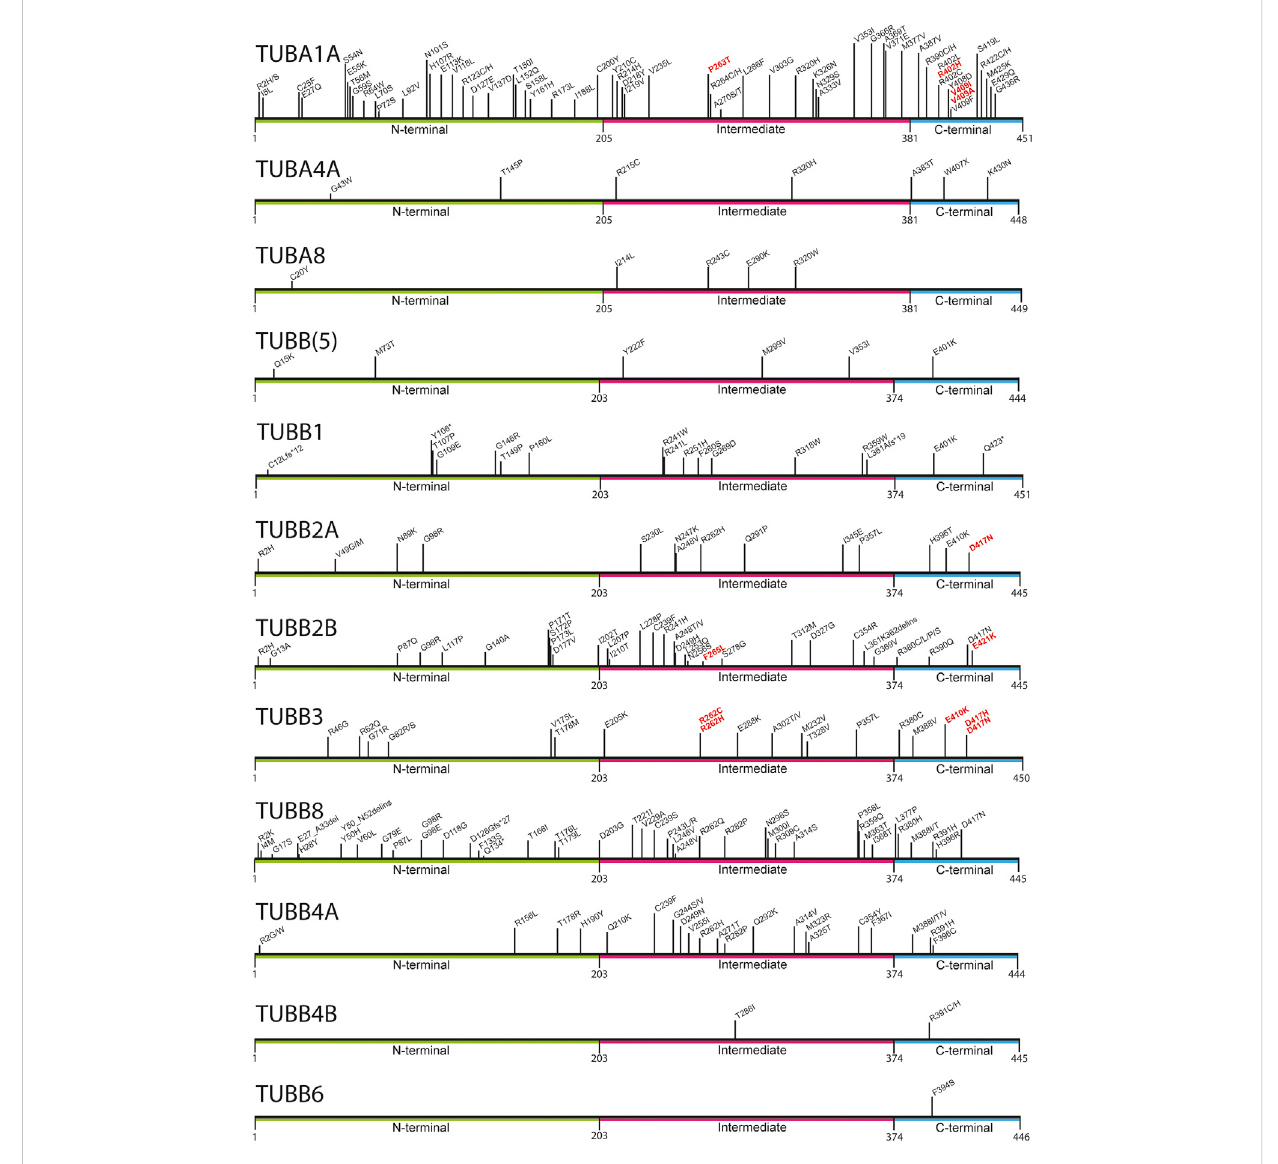
Mapping of pathogenic tubulin mutations across tubulin isotypes. Tubulin proteins can be divided into three regions: the N-terminal (green), Intermediate (pink), and C-terminal (blue) domains. The latter constitutes the major MAP-binding region of tubulin. Variants shown to affect MAP interaction are highlighted in